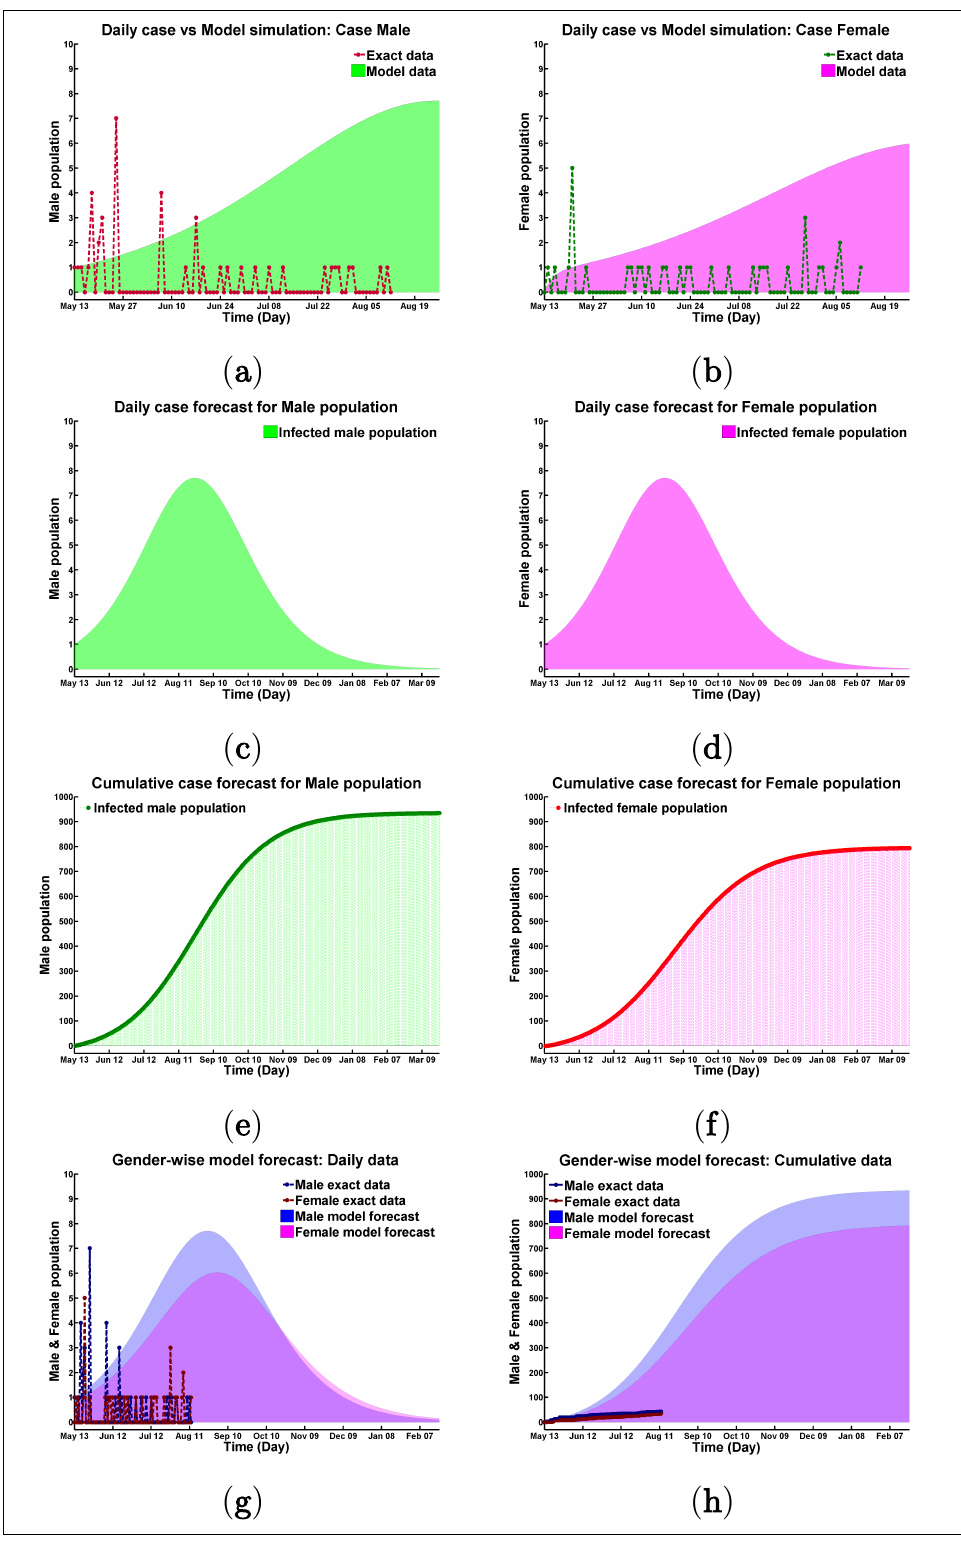
Figure 7: Visual presentation of Gender disparity for model good fitting with real data. Figure A2. Visual presentation of Gender disparity of a model that has a good fitting with real